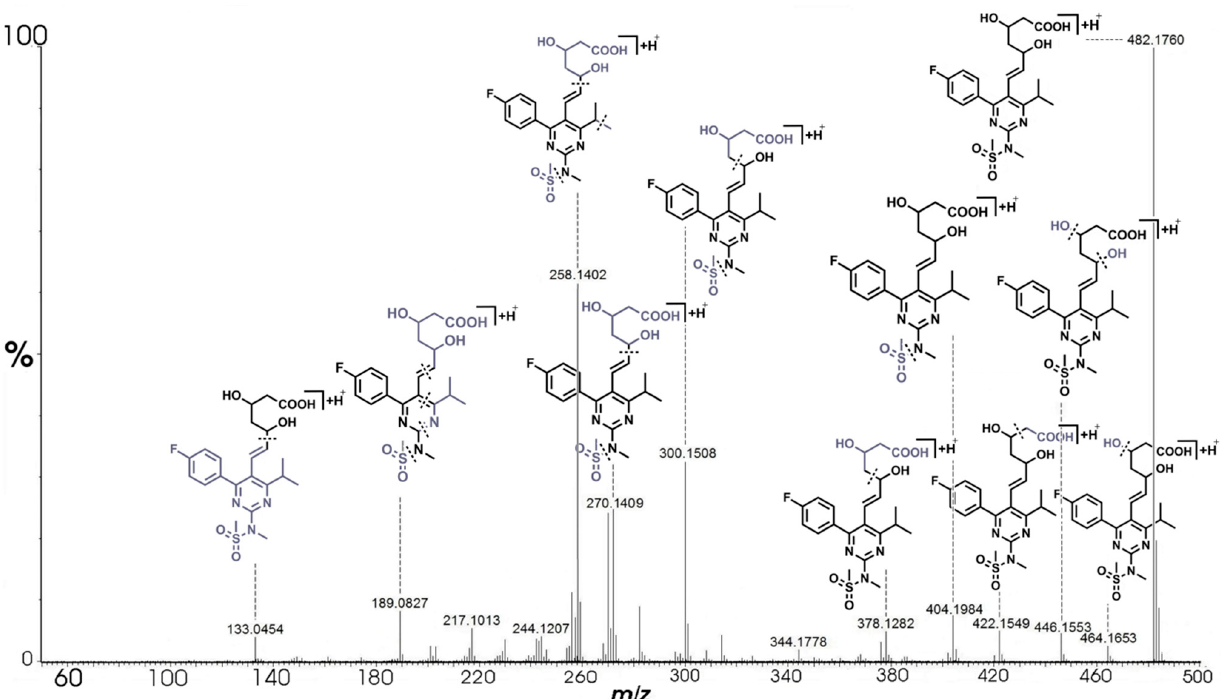
Figure 3. Fragmentation MS/MS spectra of RSV [M + H] + ion (precursor ion mass m/z 482.1760) obtained by using collision energy of 25 V.